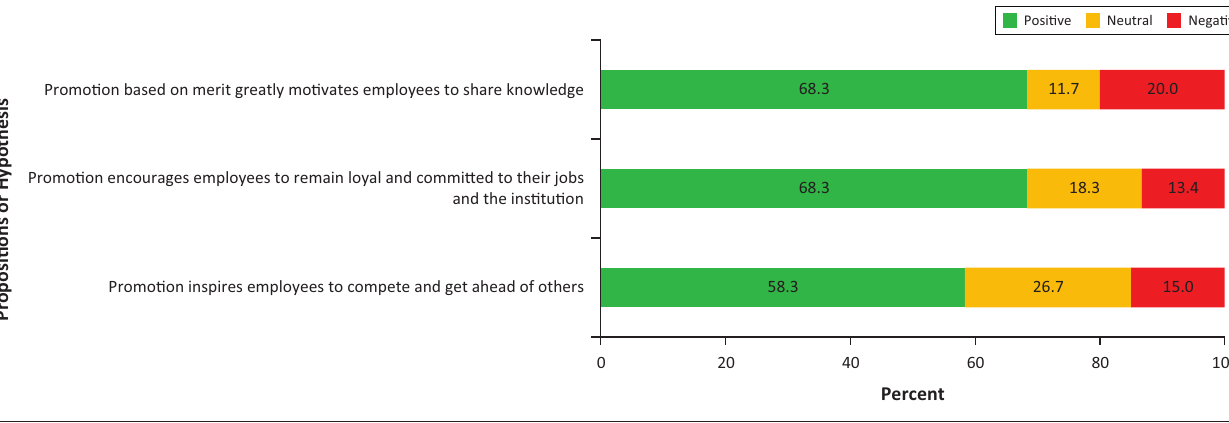
FIGURE 3: Promotion for knowledge-sharing in higher education institutions ( n =